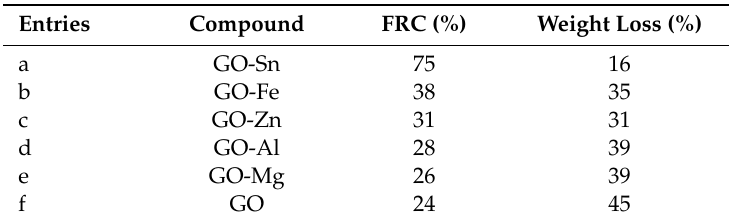
Table 2. Fraction of reduced carbon (%) calculated by NMR and weight loss (%) calculated by TG-DTGA for GO-Sn, GO-Fe, GO-Zn, GO-Al, GO-Mg and in GO